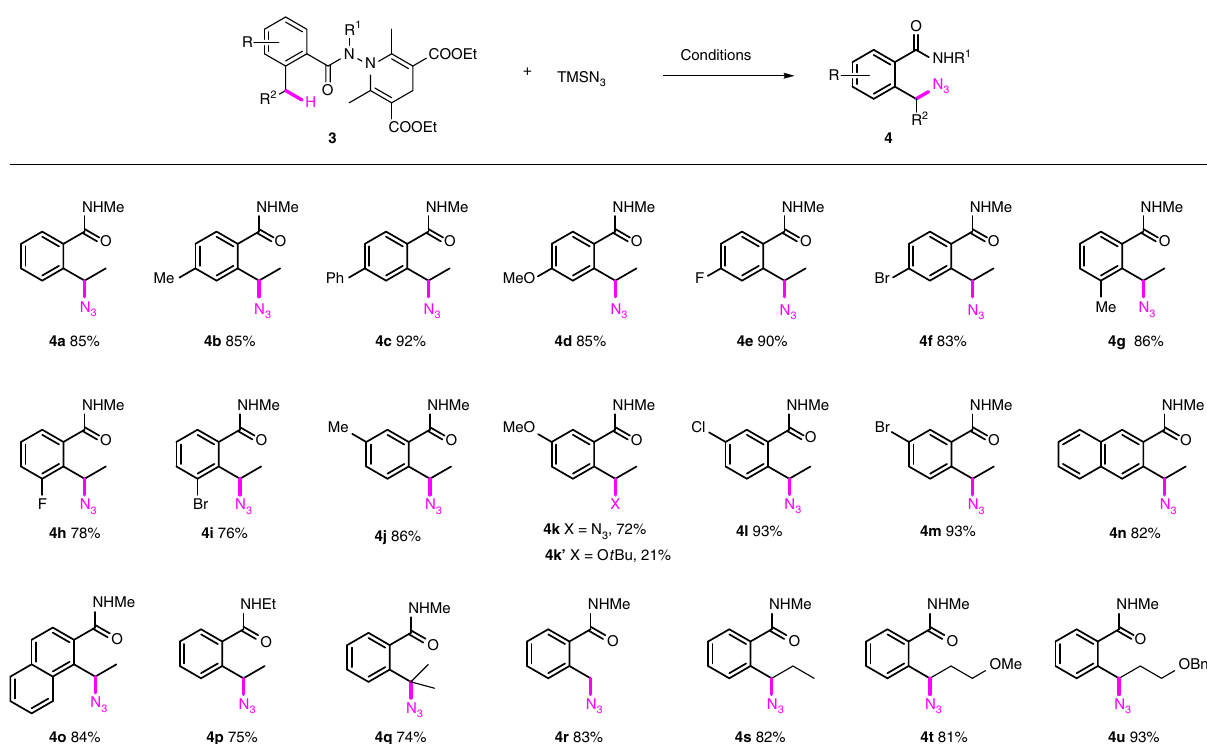
Fig. 2 γ -Azidation of 2-alkyl benzohydrazides. 3 (0.1 mmol), TMSN 3 (0.2 mmol), Cu(MeCN) 4 PF 6 (0.04 mmol), MeCO 2 O t Bu (0.2 mmol), t BuOH (2.0 mL, c 0.05 M), 50 °C, 2 h